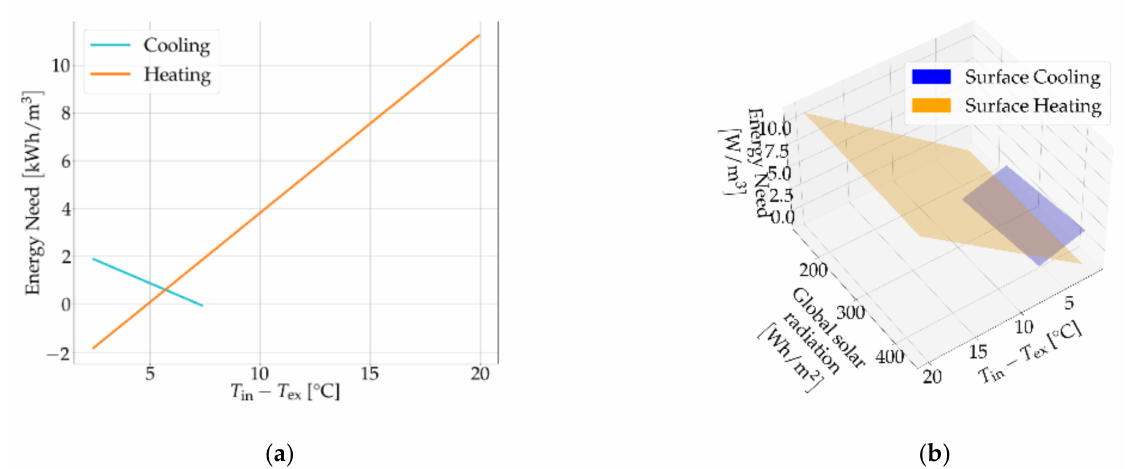
Figure 5. 1D ( a ) and 2D ( b ) energy signatures with weekly data aggregation for best case in terms of total annual energy needs (ceiling insulation 30 cm, external wall insulation 30 cm and triple glazed